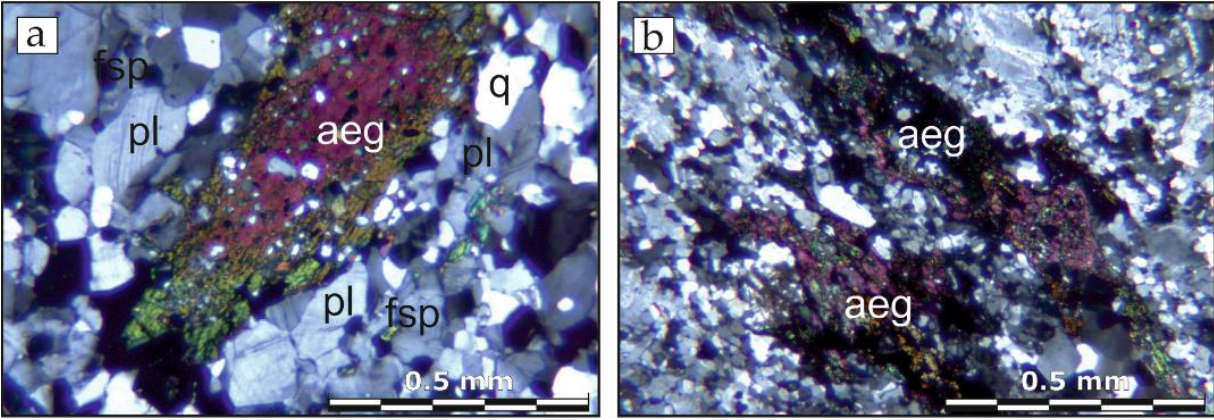
Figure 5. Metasomatic porphyroblasts of aegirine: ( a ) in granite, ( b ) in granite gneiss. Crossed nicols. q — quartz, pl — plagioclase, fsp — K-feldspar, aeg — aegirine.